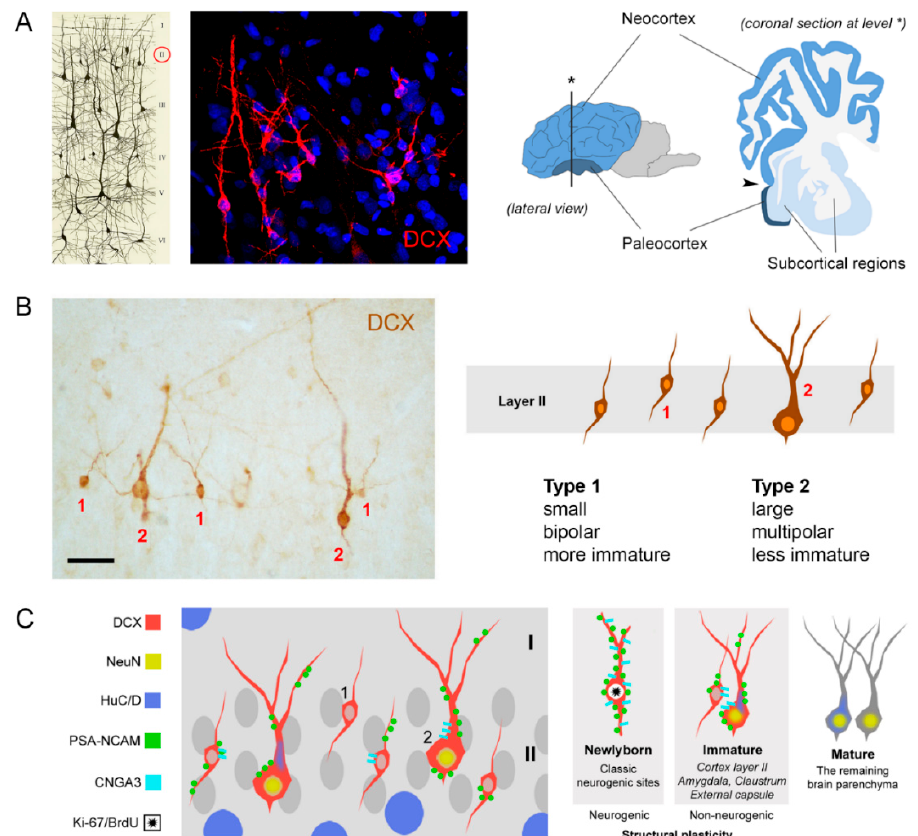
Figure 3. Non-newly generated immature neurons (nng-INs) in the cerebral cortex. ( A ) Cortical nng-INs are detectable by doublecortin (DCX) staining in layer II; in rodents, they are restricted to the paleocortex (right); arrowhead: Limit between paleo- and neo-cortex. ( B ) They occur in two different morphological types: Type 1 (small, bipolar) and type 2 cells (large, multipolar); ( C ) the nngIN cell types show different degree of immaturity: Type 1 cells are more immature than type 2 cells, as revealed by a different combination of markers. Modified from: (A) [71,108]; (C) [35].